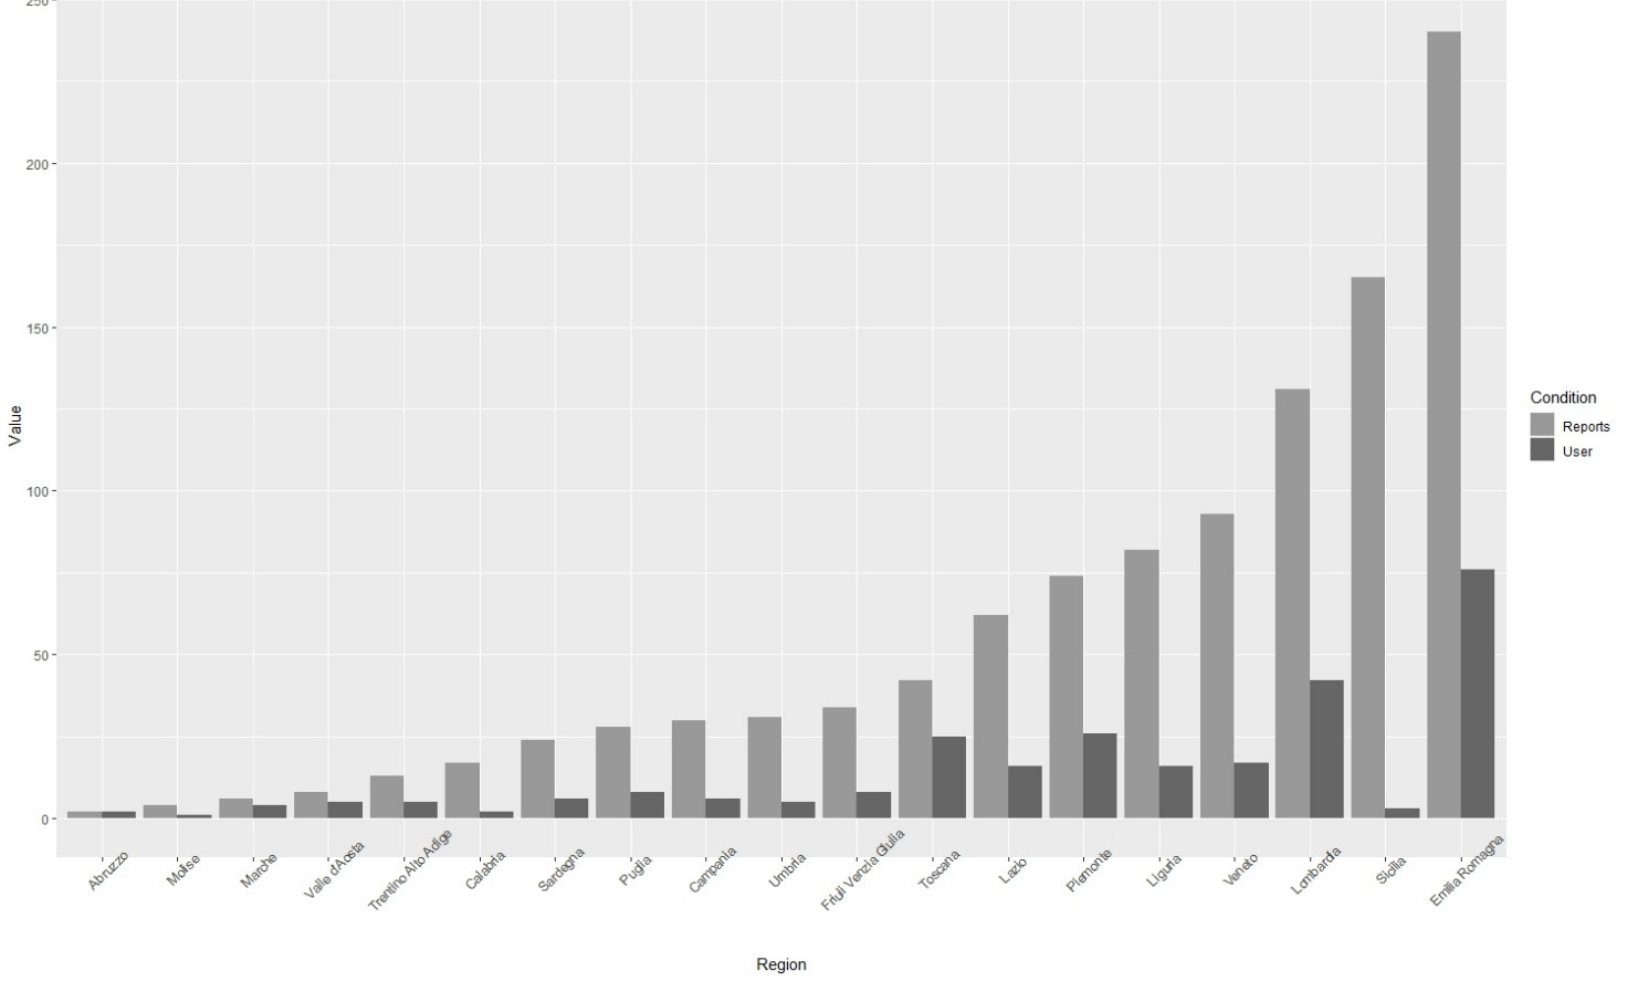
Figure 3. Number of reports and number of users in the different Italian regions.